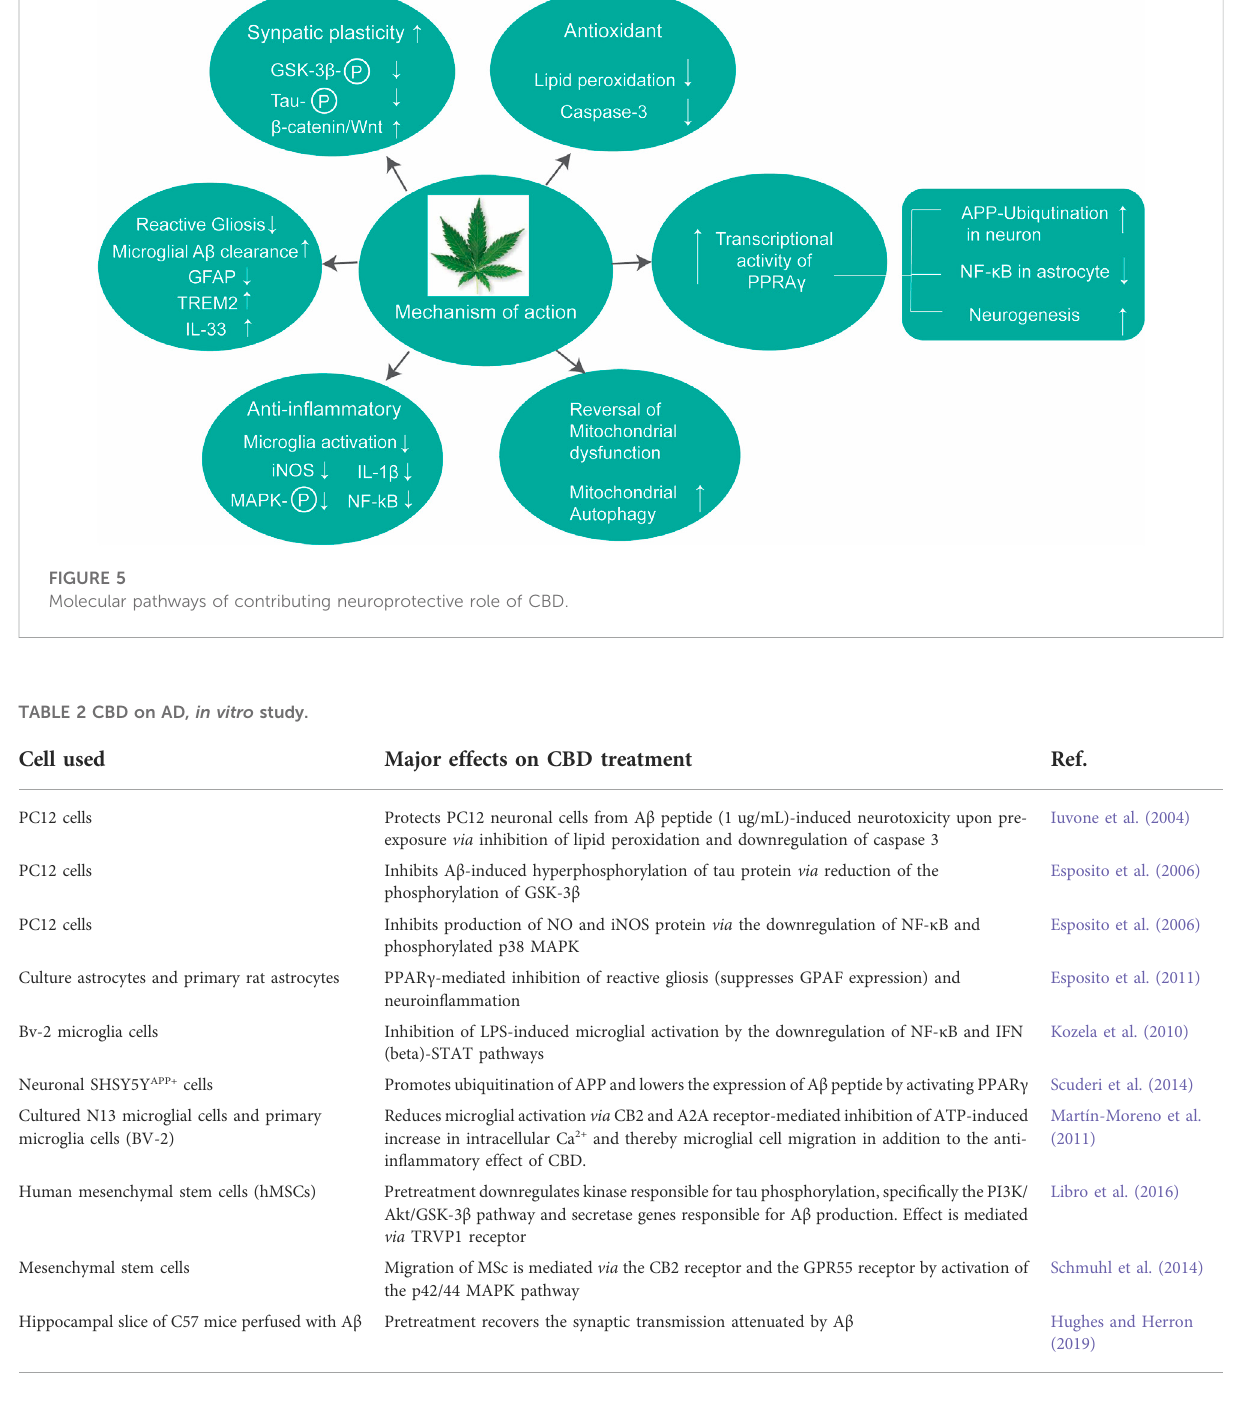
neuroprotective properties are summarized in Figure 5 and Table 2. The neuroprotective ef fi cacy of CBD has also been evaluated using different animal models of AD including pharmacological